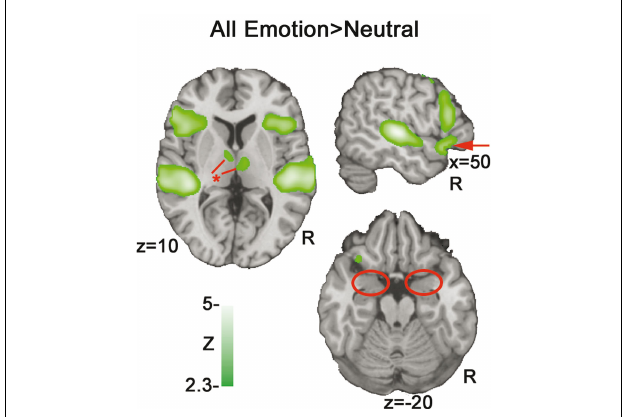
FIGURE 4 | All emotions > neutral. A subtraction of neutral activation from all emotions (anger, fear and happiness) indicates activation clusters bilaterally in posterior superior/middle temporal gyrus (pSTG/ pMTG), inferior frontal gyrus (IFG) and orbitofrontal cortex (OFC). The markers in red illustrate differences between this contrast and the subsequent parametric analysis: Arrow = OFC activation; * = thalamic activation; circles = absence of amygdala activation